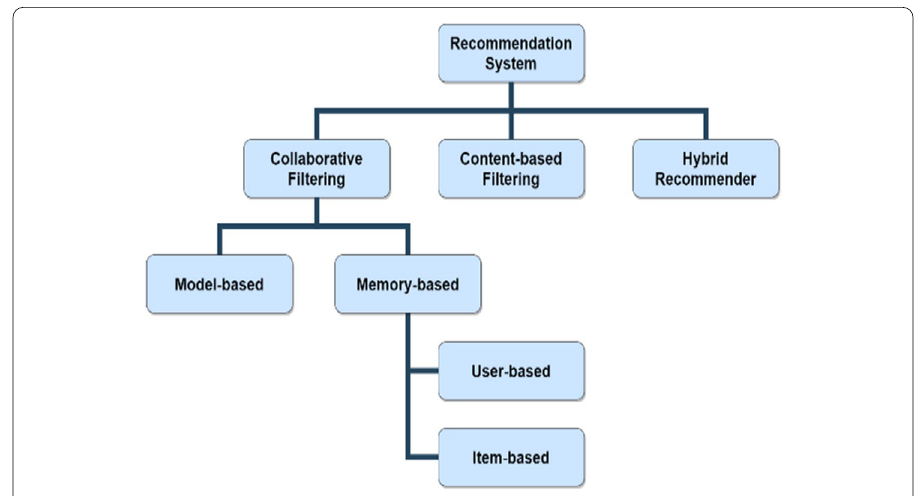
Fig. 1 Recommendation